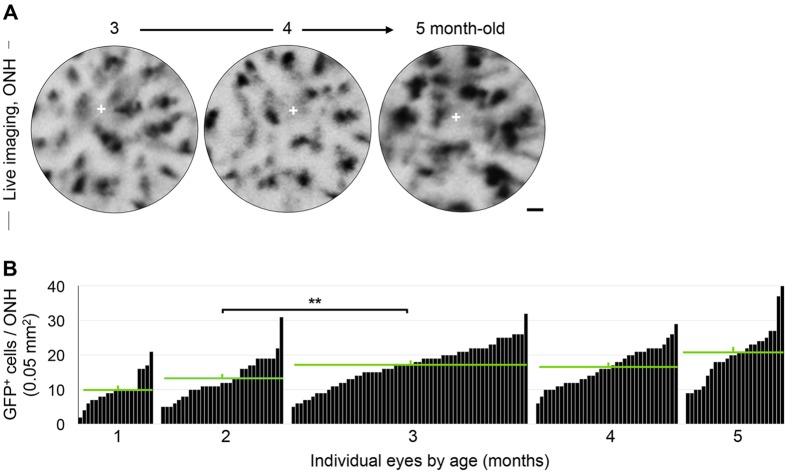
Eyes show large variability in their levels of ONH microgliosis at pre-neurodegenerative ages. (A) Sequential imaging of the same ONH area at 3, 4 and 5 months revealed dynamic changes in GFP+ cell numbers and size; the cross indicates the ONH center. (B) Total number of GFP+ cells per ONH at 1, 2, 3, 4 and/or 5 months of age (n=19-59 images per age). Data with eye identification and late nerve pathology are presented in supplementary material Fig. S3. Each bar represents an individual ONH and green bars indicate mean±s.e.m. at each age group (10±1.06, 13.17±1.07, 16.85±0.77, 16.46±0.94 to 19.93±1.53, respectively). The average number of GFP+ cells per ONH rises with age and significantly increases between 2 and 3 months (**P<0.01; Student's t-test). Scale bar: 25 µm.